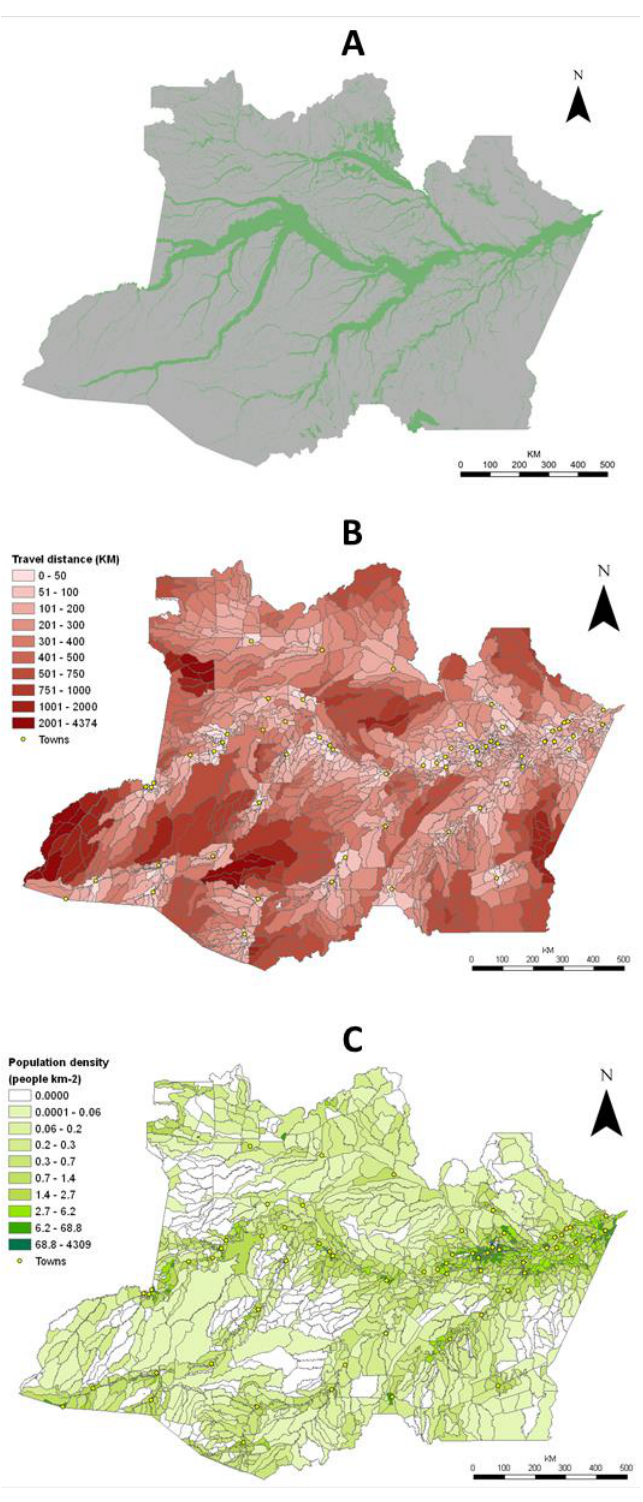
Figure A1. Variables assigned to census sectors: (A) Land-form based on coverage of flooded várzea (green) and unflooded terra firme (gray); (B) Travel distances to the local urban center (calculated from network analysis; Parry et al. 2010a), and (C) Human population density calculated from the IBGE 2007 population